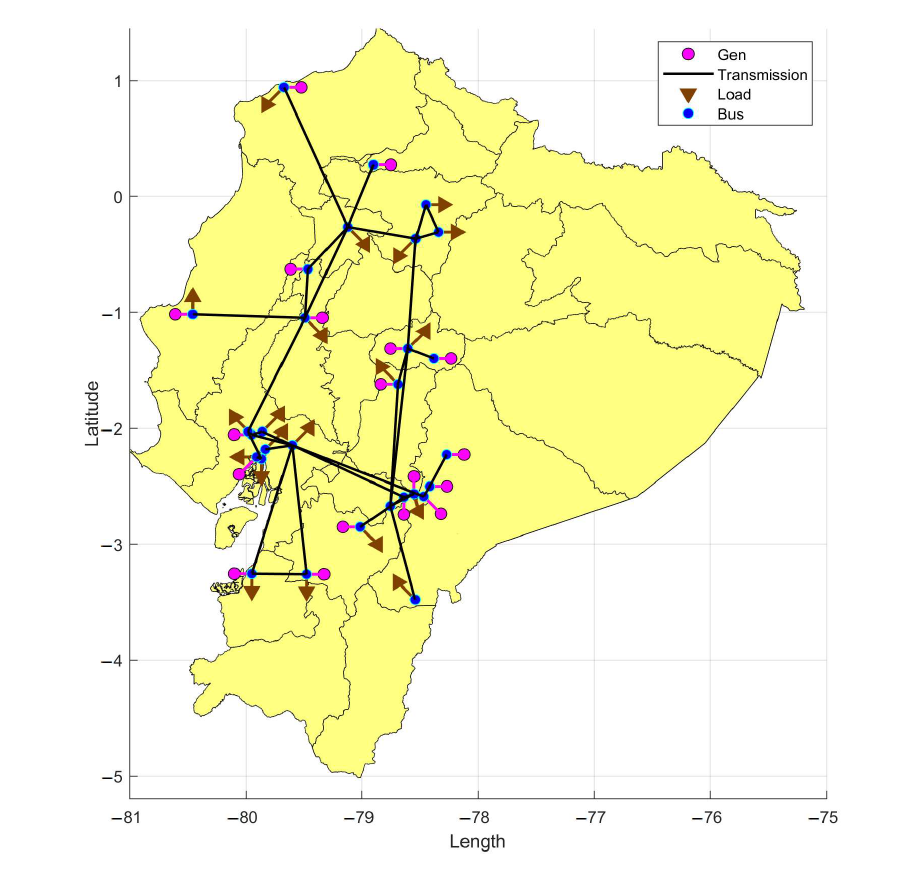
Figure 1. Ecuadorian electrical